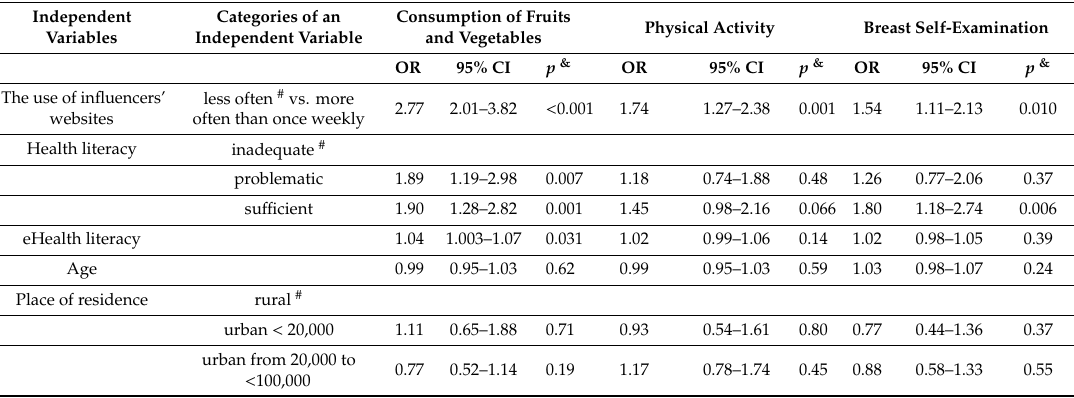
Table 5. Multivariate logistic regression model for the consumption of fruits and vegetables, physical activity, and breast self-examination as dependent